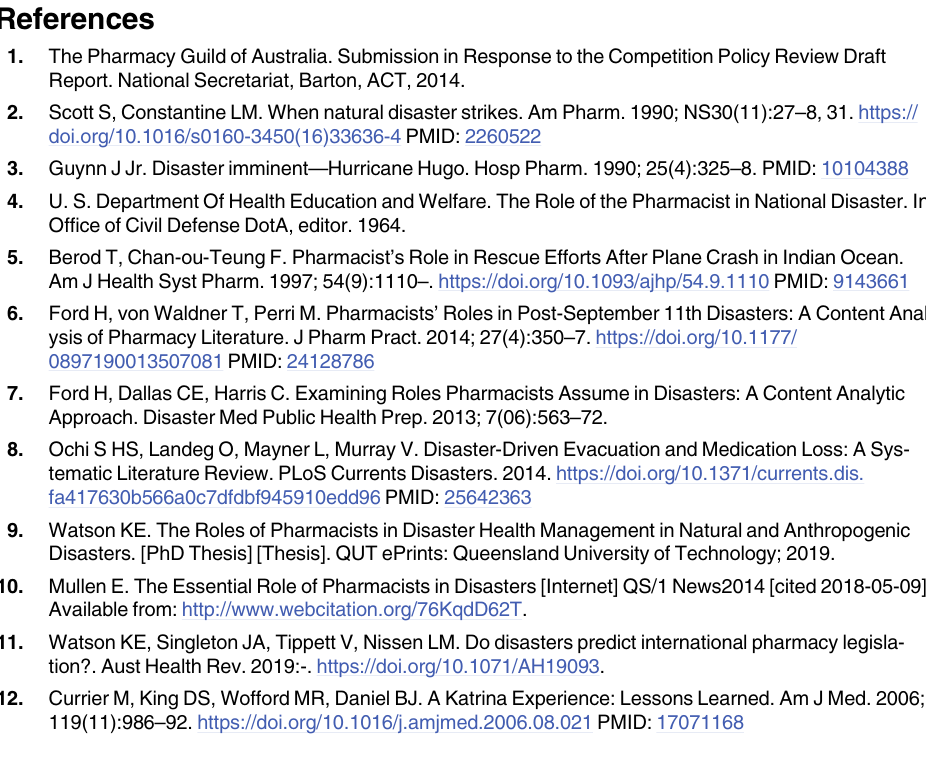
S4 Table. Final round Delphi study survey on roles which had not yet reached consensus in the previous two rounds and included the comments from the